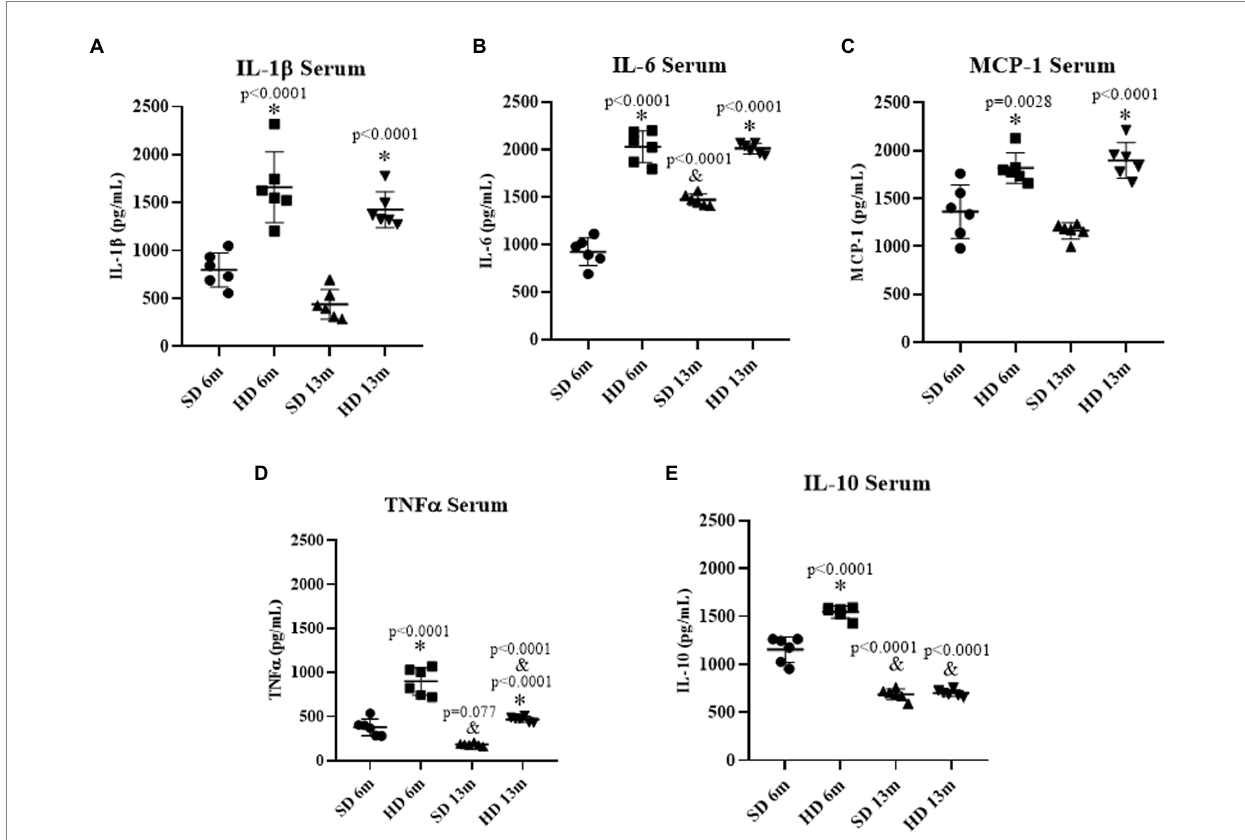
FIGURE 2 Serum inflammatory profile. The levels of IL1 β (A) , IL6 (B) , MCP-1 (C) , TNF α (D) , and IL10 (E) were determined by ELISA ( n = 6 SD and n = 6 HD). The data represent the mean ± standard deviation and were analyzed by two-way ANOVA, followed by Tukey’s post hoc test. The significant differences between groups with respect to the SD are marked with ∗ , and differences at different ages are marked with & p <